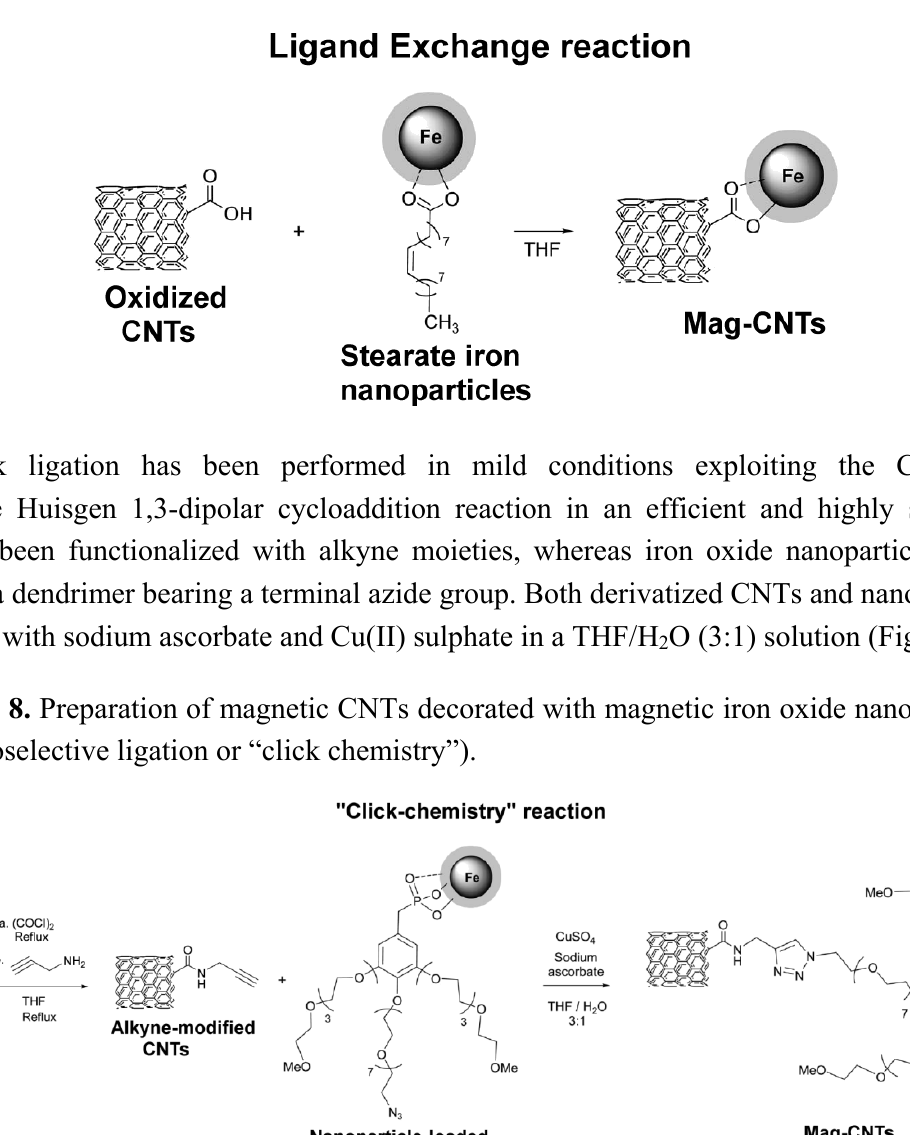
Figure 7. Preparation of magnetic CNTs decorated with magnetic iron oxide nanoparticles (ligand exchange reaction). The magnetic core is exchanged by passing from the stearate molecule to the CNTs.